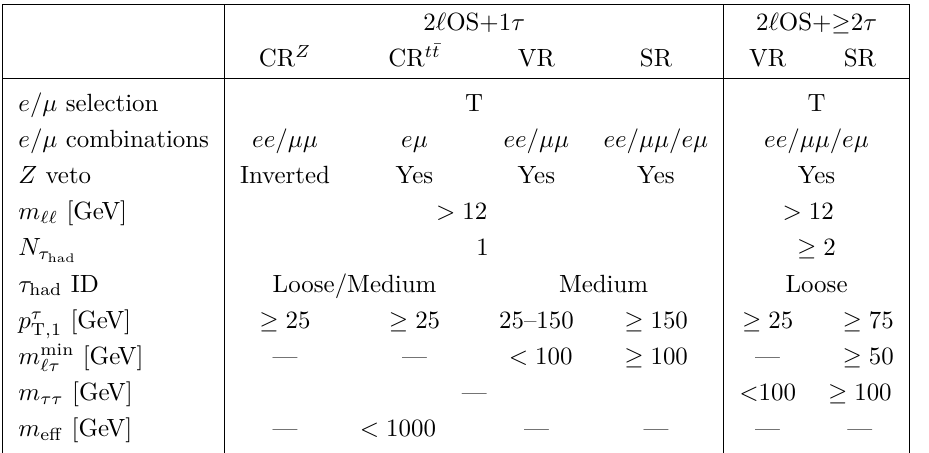
Table 4. Summary of event categories in the 2 ‘ OS+ ≥ 1 τ channel. All events are required to satisfy the preselection requirements. “T” denotes the Tight light-lepton selection criteria (see table 2).